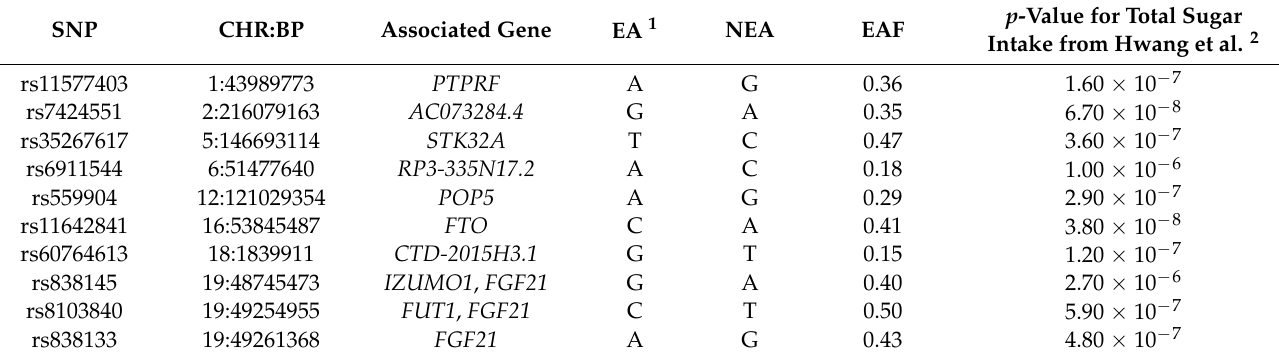
Table 2. Description and allele frequencies of the 10 primary